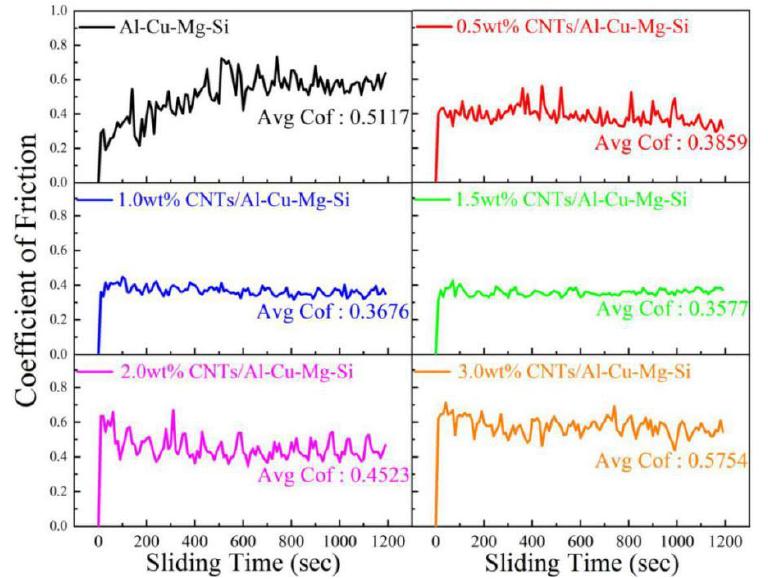
Figure 10. Plot of the coefficient of friction as a function of sliding time for. x wt%CNTs /Al-Cu-Mg-Si composites at 20 °C.